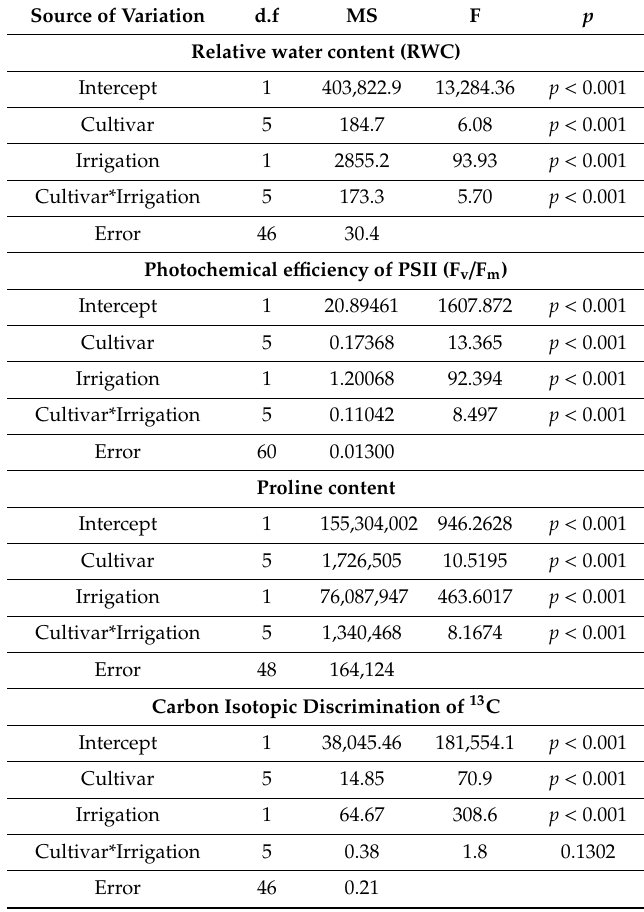
Table 1. Two-way ANOVA of the interactions between irrigations (300 mL and 150 mL) and